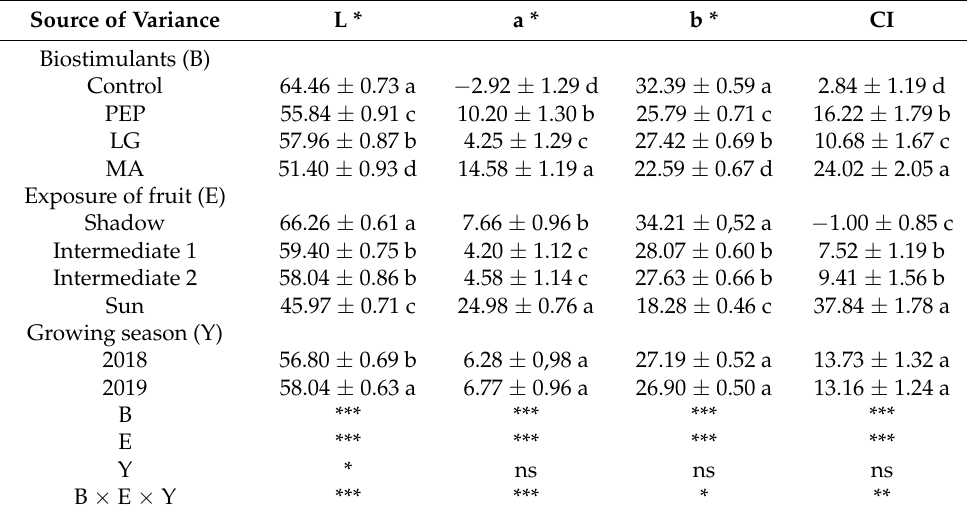
Table 2. Effect of biostimulants LG (seaweed mix + zinc + potassium), PEP (protein hydrolysates), and MA (micro algae) on the Annurca fruit color (L* a* b* and color index (CI)) with different exposure at harvest. L* indicates lightness, and a* and b* are color directions: +a* is the red axis, -a’ is the green axis, +b* is the yellow axis and − b* is the blue